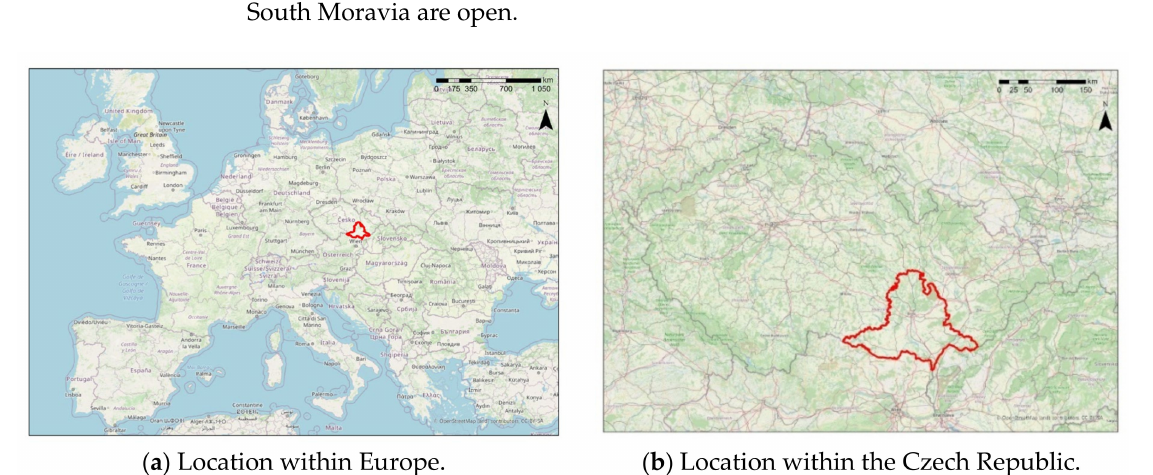
Figure 2. ( a , b ) Location of the South Moravian